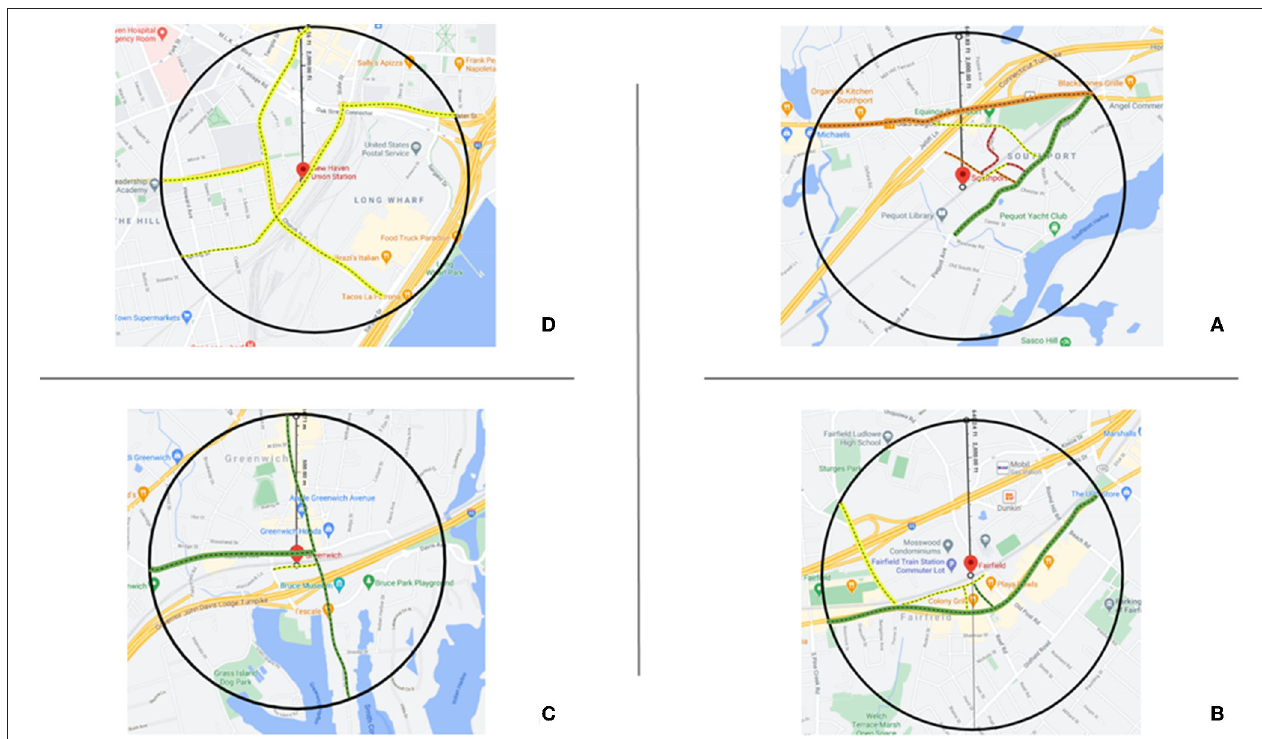
FIGURE 3 | (A–D) Sample analysis maps for transit-supportive street